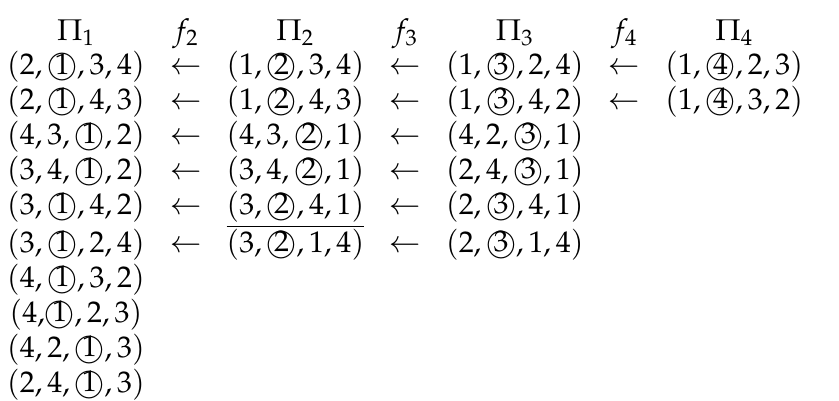
Figure 1. Injective maps f 2 , f 3 , f 4 induced by G = [ 50;40,30,20,10 ] . The circled number (player) denotes the pivot